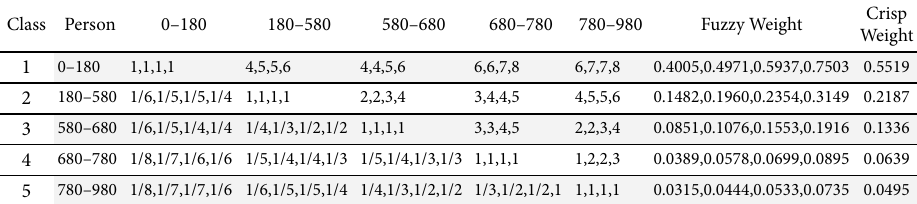
Table 3. Fuzzy AHP-decision matrix and fuzzy weights, Population Density (C11)